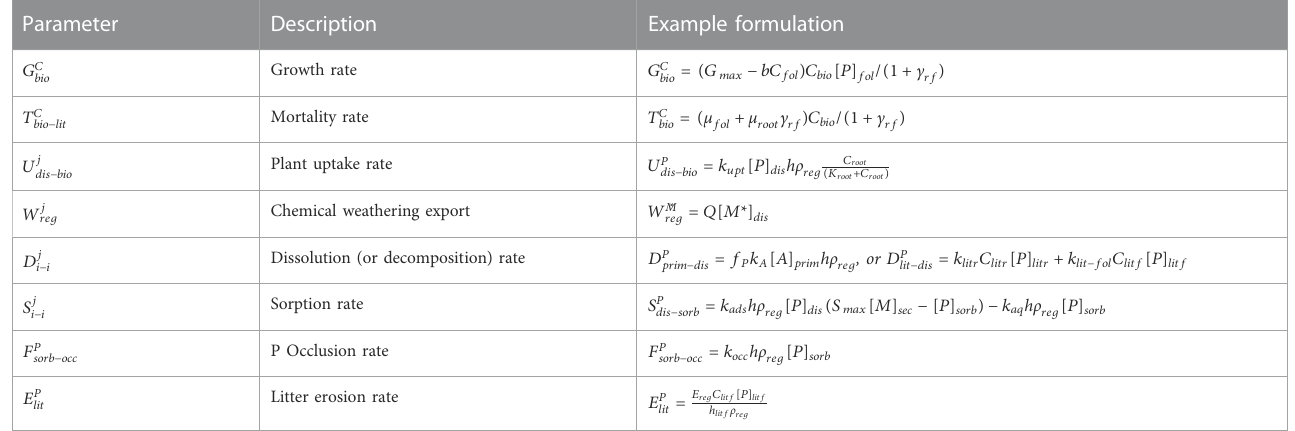
TABLE 2 Model computed fl uxes where j corresponds to the element ( e.g ., P, Ca ) or component ( e.g. , M, A, etc. ) and i corresponds to the reservoir, such that the fi rst index shows the original reservoir and the second the reservoir to which the fl ux is transferring mass.